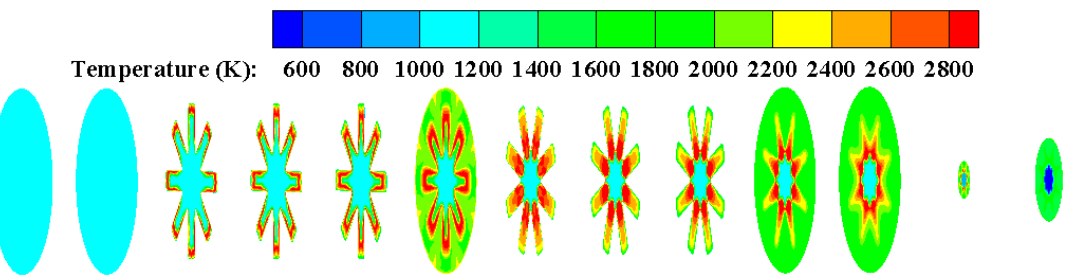
Figure 15. Temperature distribution in the motor for case rot-1/2-40.